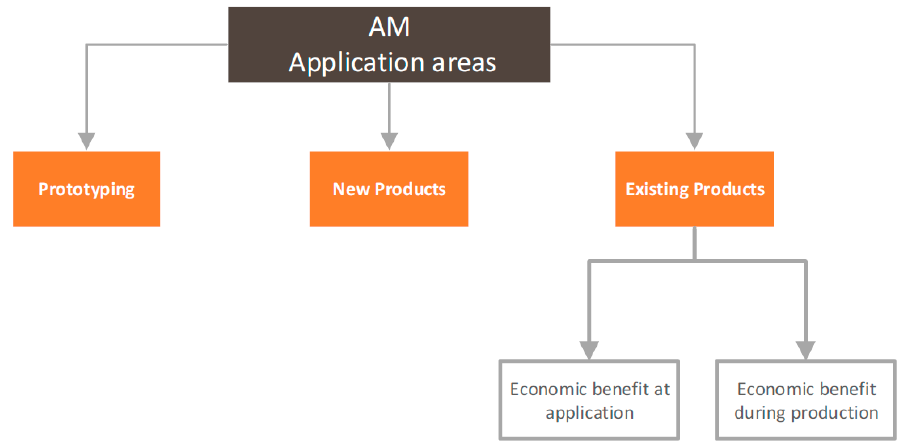
Figure 5. AM application areas, created based on [28].